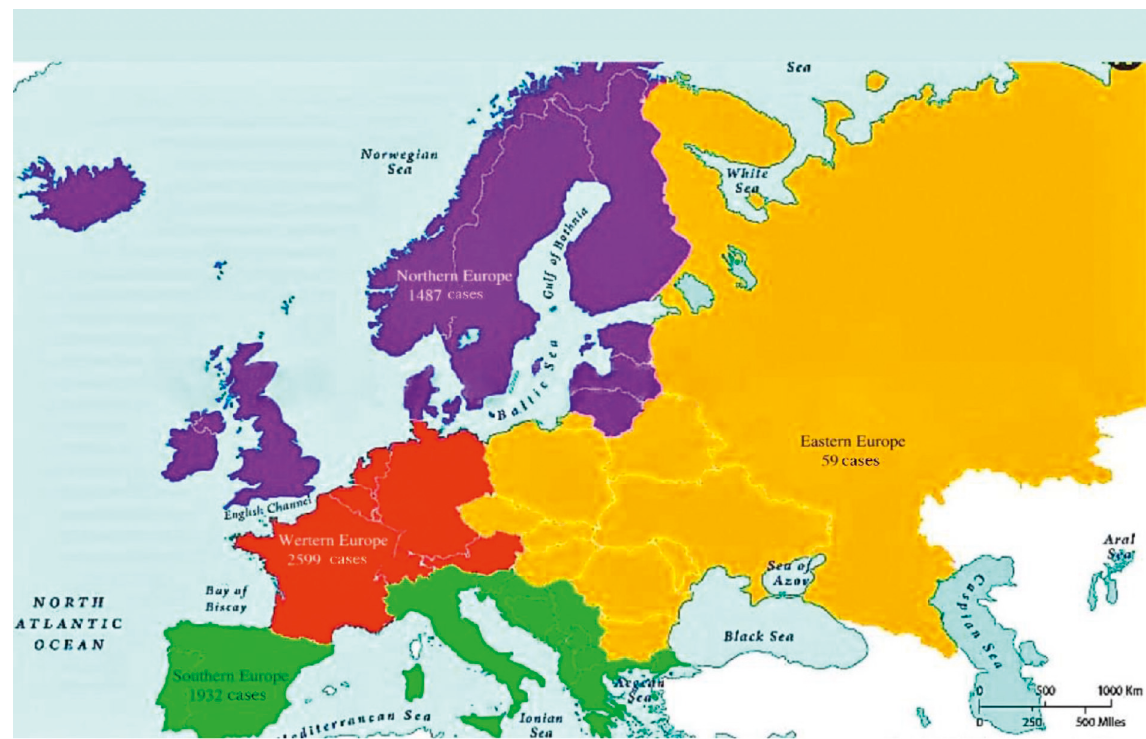
Figure 1: Total number of human monkeypox cases in eastern, western, southern, and northern subregions of Europe (data presented from May 7, 2022, to July 7, 2022).